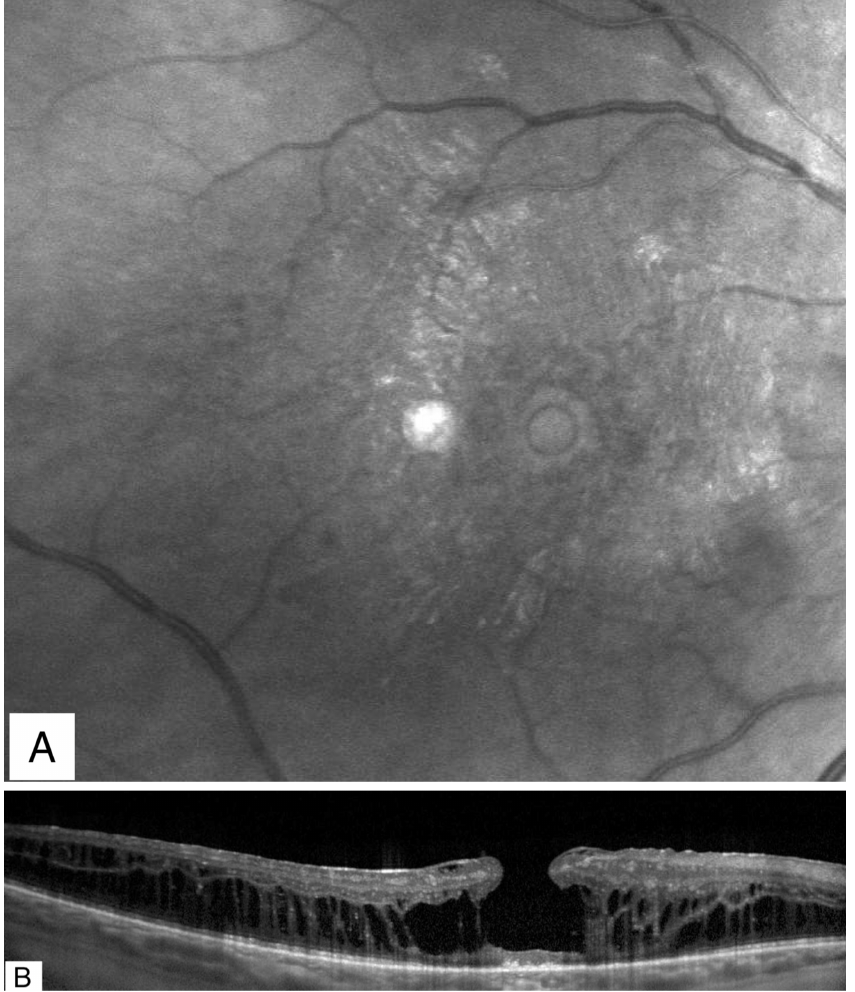
Figure 4. A 65-year-old woman with long-standing diabetic macular edema which led to a secondary LMH. The visual acuity was counting fingers. ( A ) Infrared reflectance imaging showing a round punched-out lesion in the center of the macula simulating a full thickness macular hole. ( B ) Spectral domain optical coherence tomography demonstrating residual tissue at the foveal floor confirming the presence of a secondary LMH rather than a FTMH. LMH: lamellar macular hole; FTMH: full thickness macular hole.